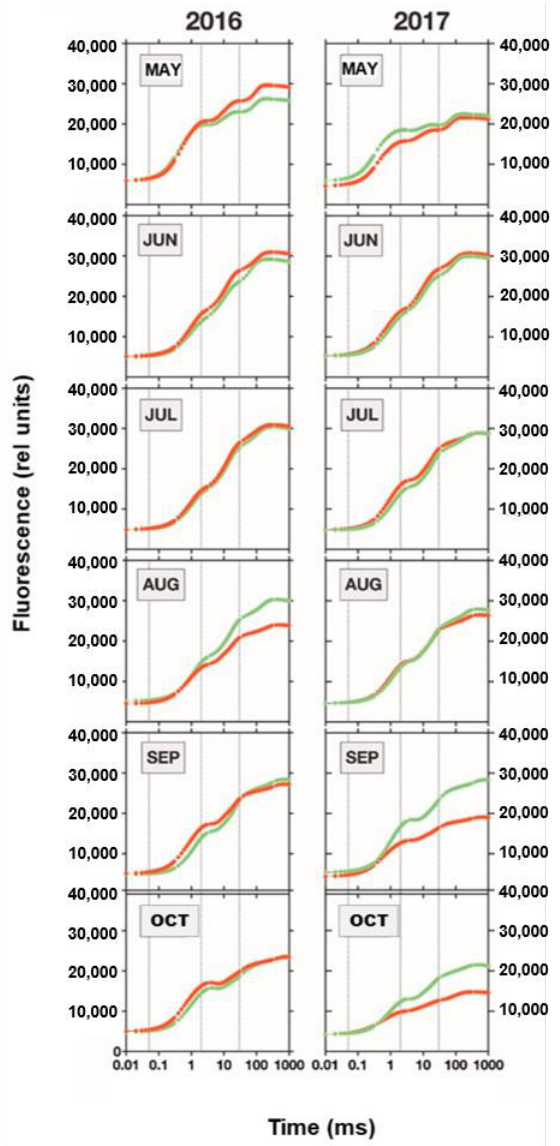
Figure 1. Fluorescence kinetics of PS II chlorophyll fluorescence; comparison of OPM-infested oak leaves (red curves) with non-infested ones (green curves) in the urban area of Rathenow, Branden- burg. May to October 2016 and 2017.